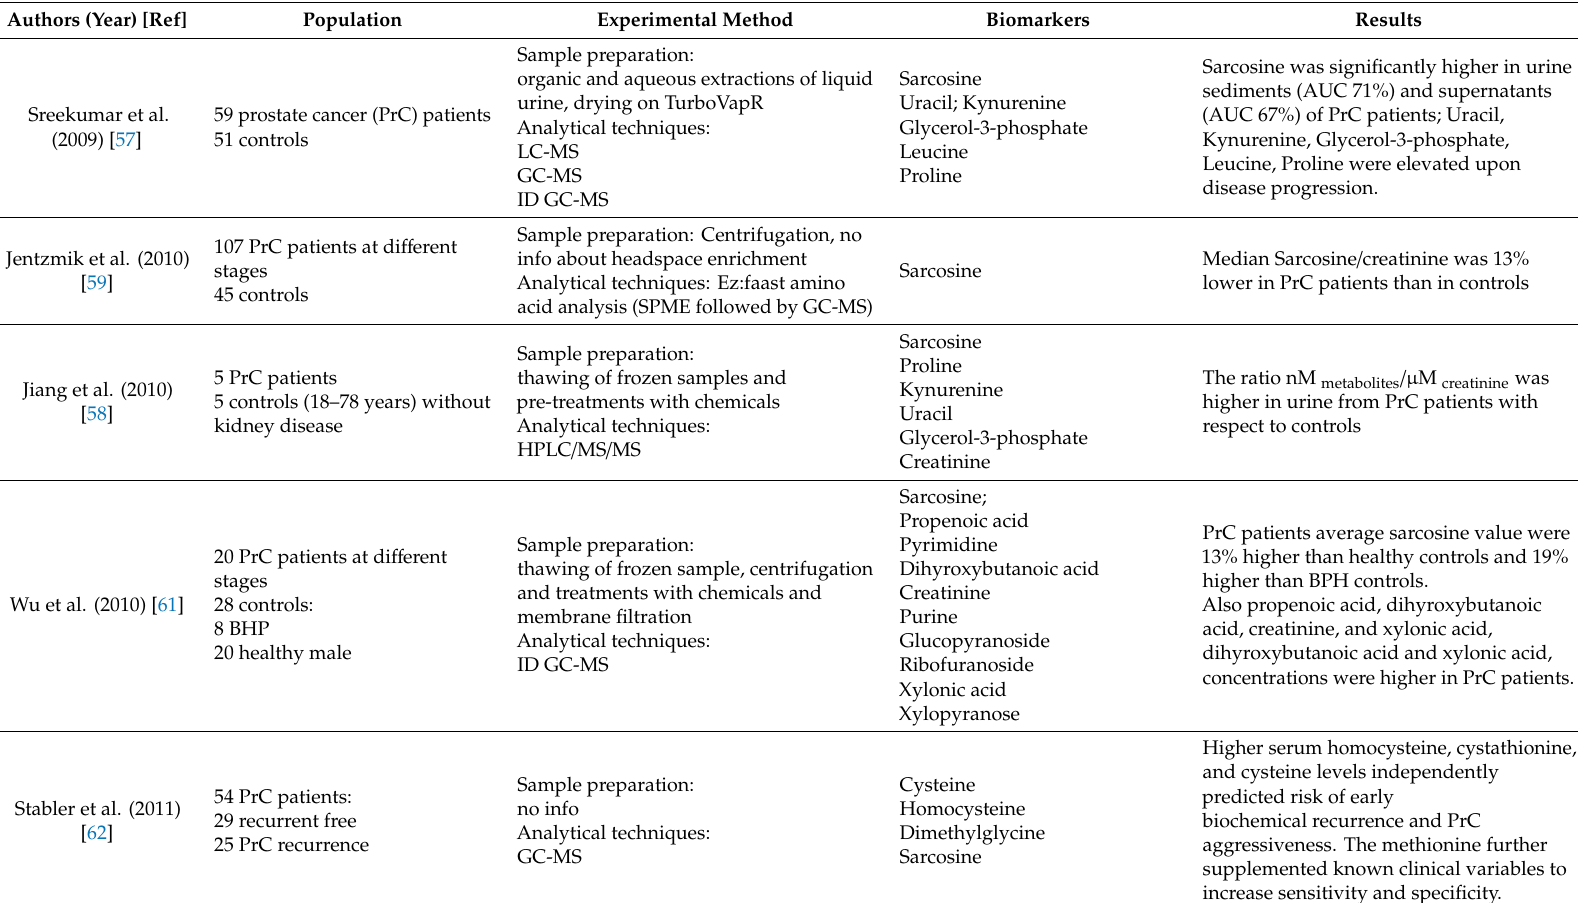
Table 3. Literary studies investigating urinary prostate cancer